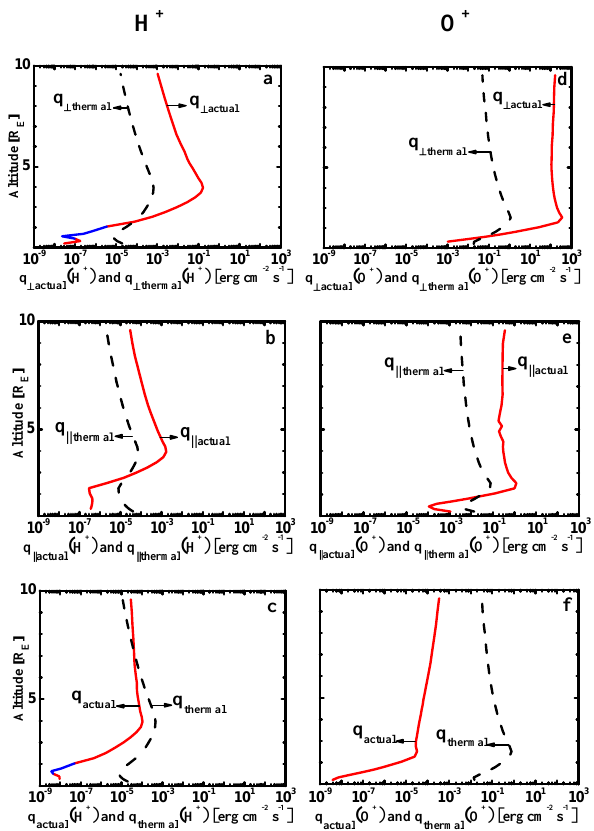
Figure 4. Altitude profiles for actual (solid lines, the line shows the magnitude of the actual heat flux, with red color indicating posi- tive values and blue color indicating negative values) and “thermal- ized” heat fluxes (dashed lines) of H + ions (left panels) and O + ions (right panels) in the auroral region. The heat fluxes considered here are perpendicular heat fluxes (top panels), parallel heat fluxes (mid- dle panels) and total heat flux (bottom panels). The unit of the heat flux is ergcm − 2 s − 1 . The arrow and the symbol next to it represent a label for the corresponding